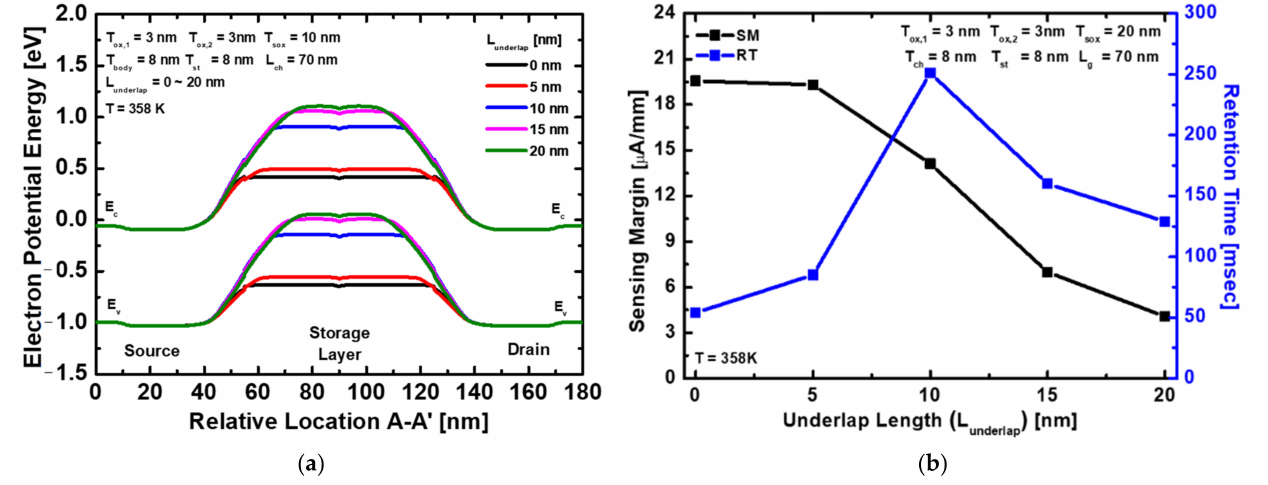
Figure 9. ( a ) Energy band diagram of the storage layer with different L underlap during hold ”1” operation. The energy band is extracted at 2 nm below the top gate oxide. ( b ) Variations in sensing margin and retention time with L underlap of proposed